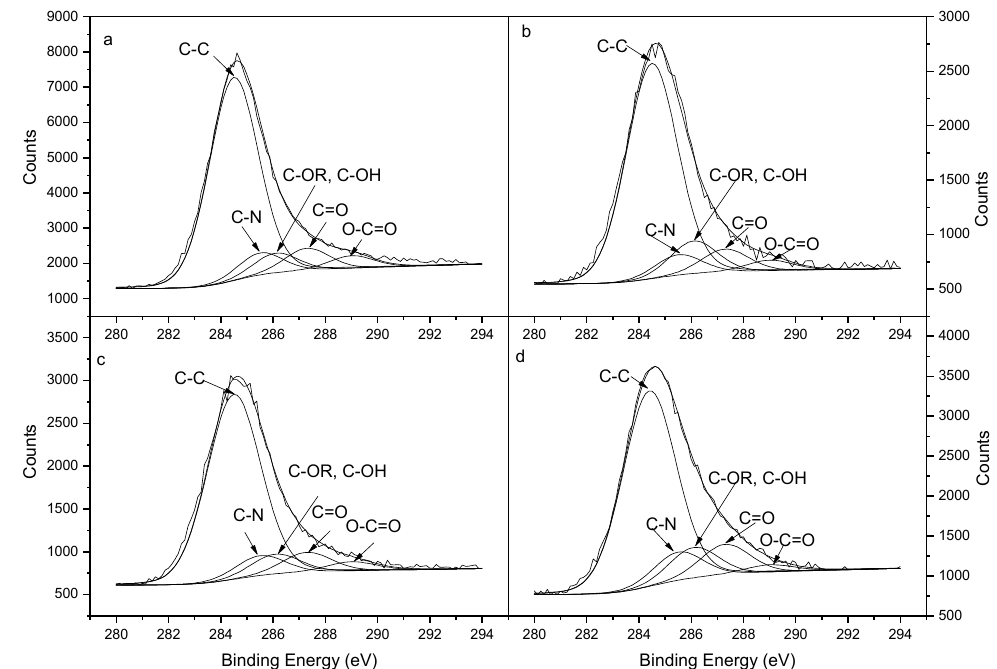
Figure 5. C1s XPS fitting curves of SBB before and after phosphate adsorptions. ( a ) C1s XPS fitting curves of SBB; ( b ) C1s XPS fitting curves of KDP-adsorbed SBB; ( c ) C1s XPS fitting curves of STPP-adsorbed SBB; ( d ) C1s XPS fitting curves of SGP-adsorbed SBB.